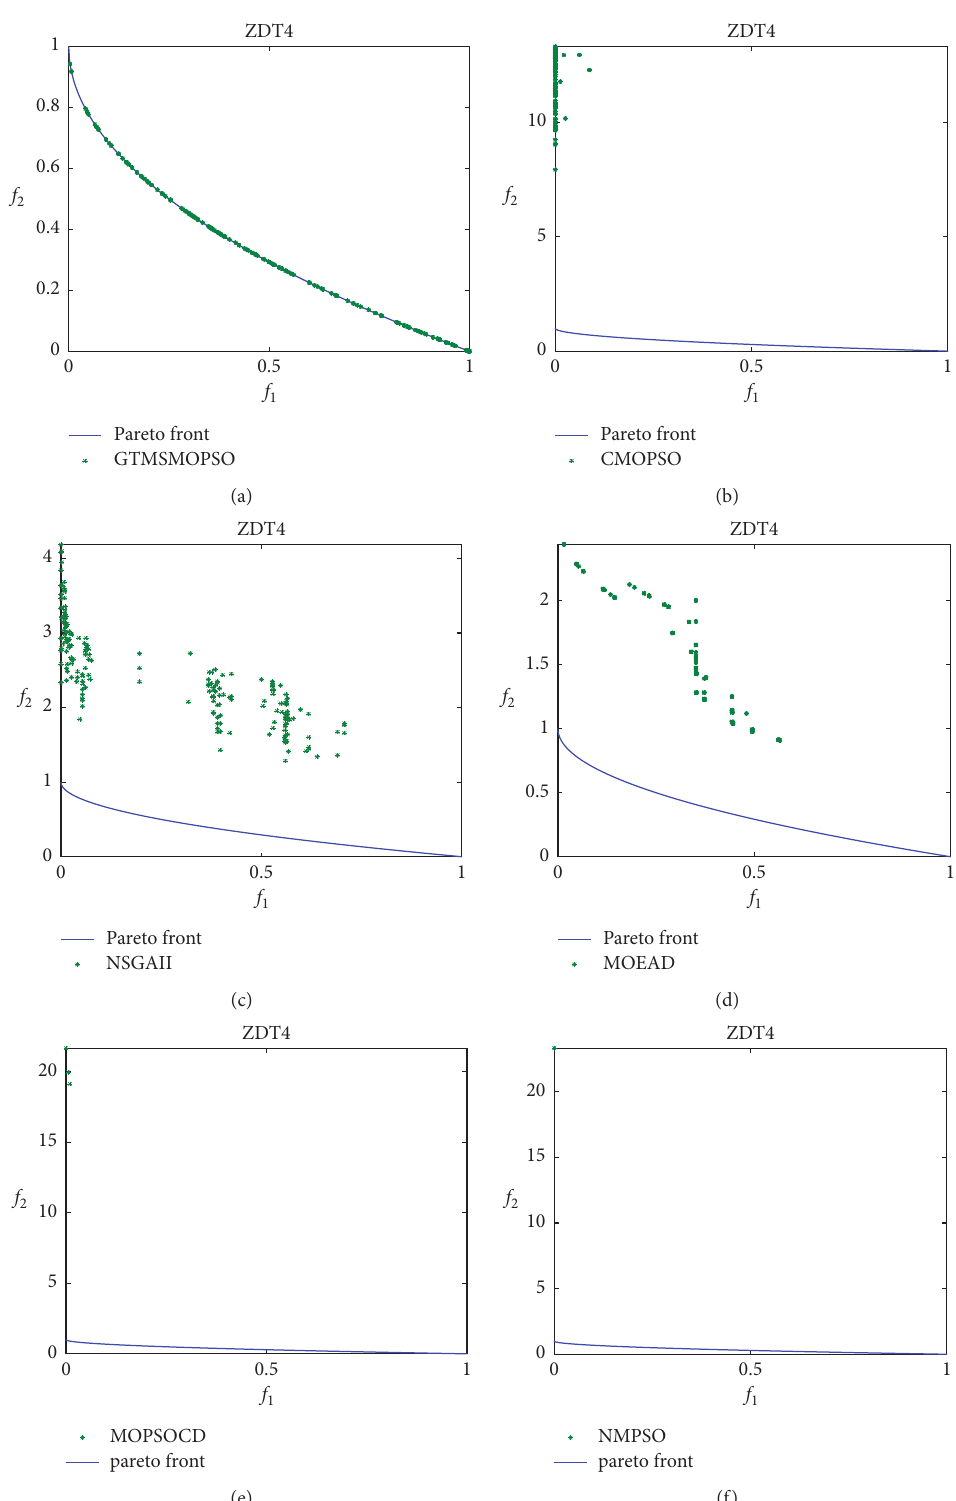
Figure 5: Pareto frontier effect of three different algorithms for ZDT4